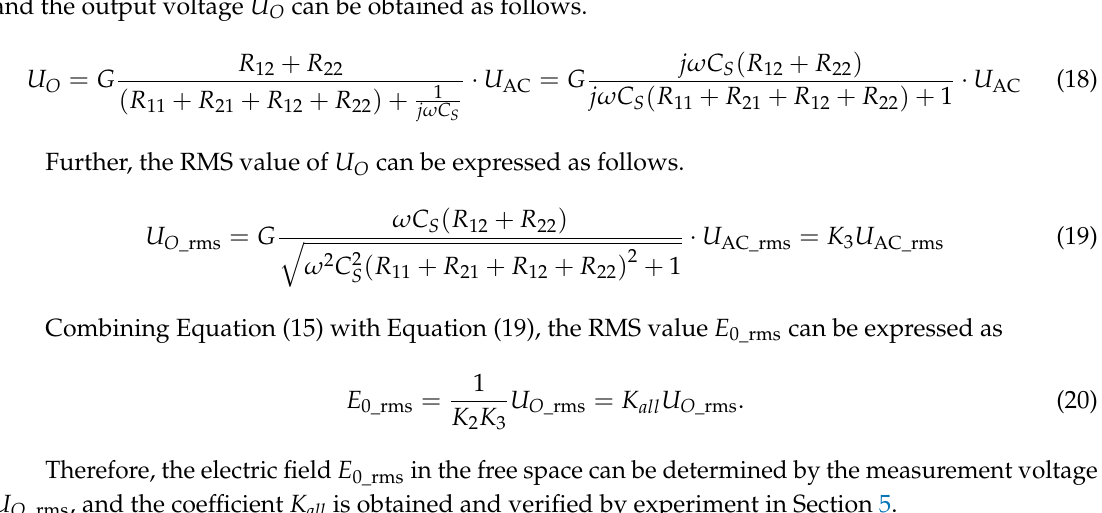
Figure 6. Time domain waveform of voltage. Table 1. U AC_rms obtained under different E 0_rms . E 0 _ rms (kV/m)